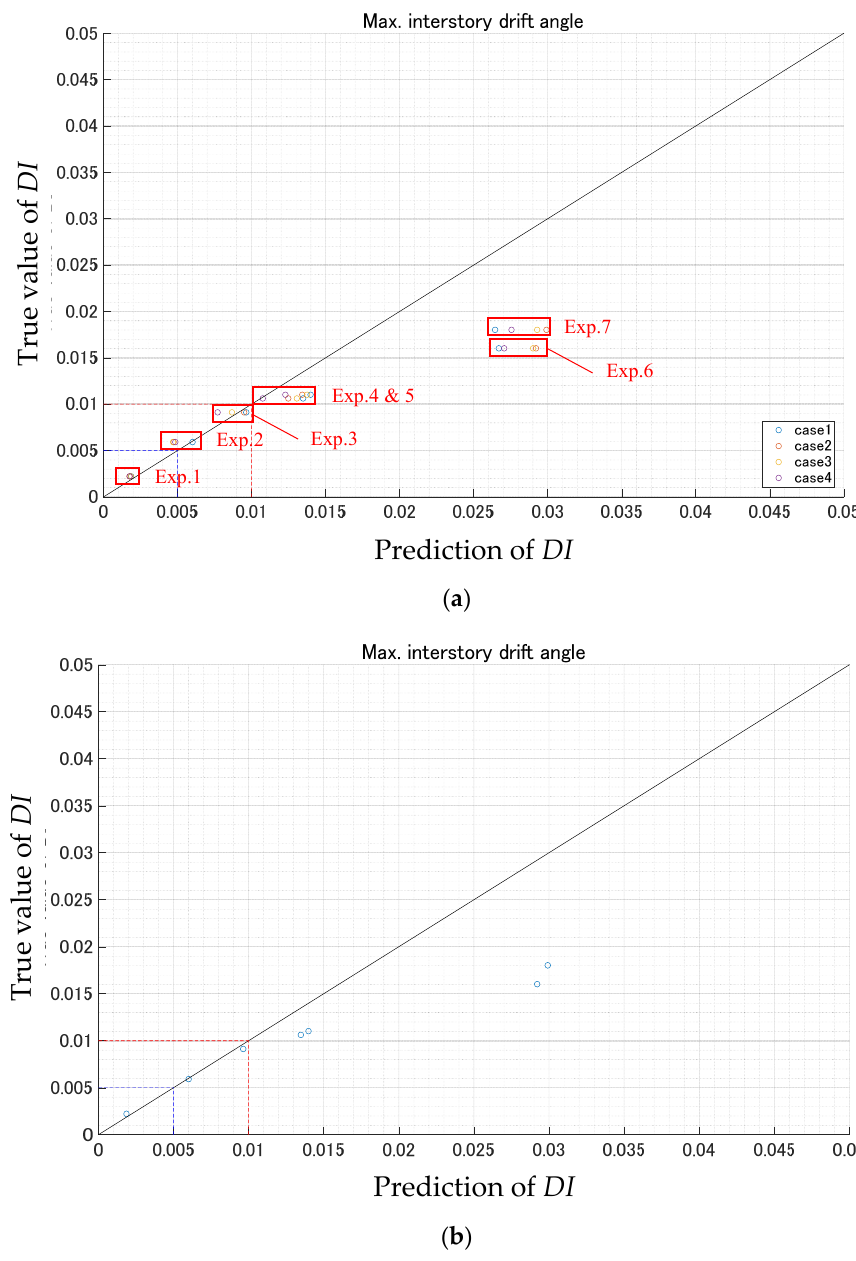
Figure 13. Scatter plot between predictions and true values from experimental data: ( a ) Results of estimation using four window cases (red: Experimental cases 1 − 7 of Table 3); ( b ) results of estimation using the maximum DI from four window cases.